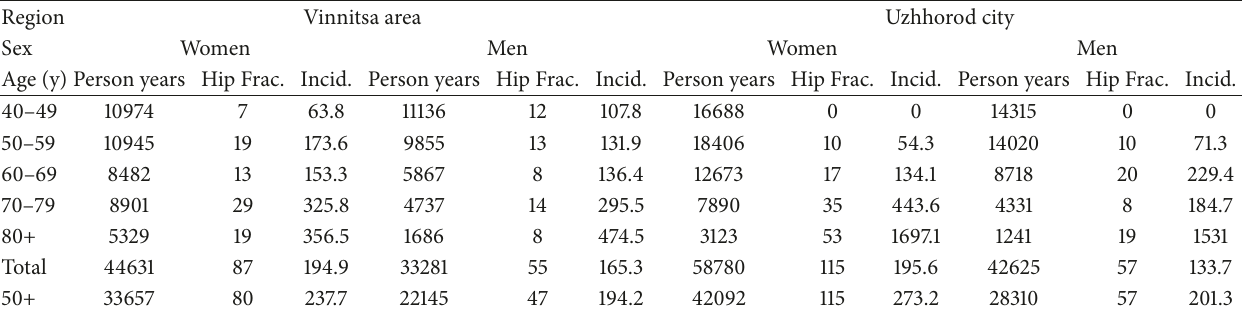
Table 2: Observation time and the number and incidence of hip fractures in women and men in the two centers of the STOP study within the age bands shown. The data for 2011-2012 are combined.